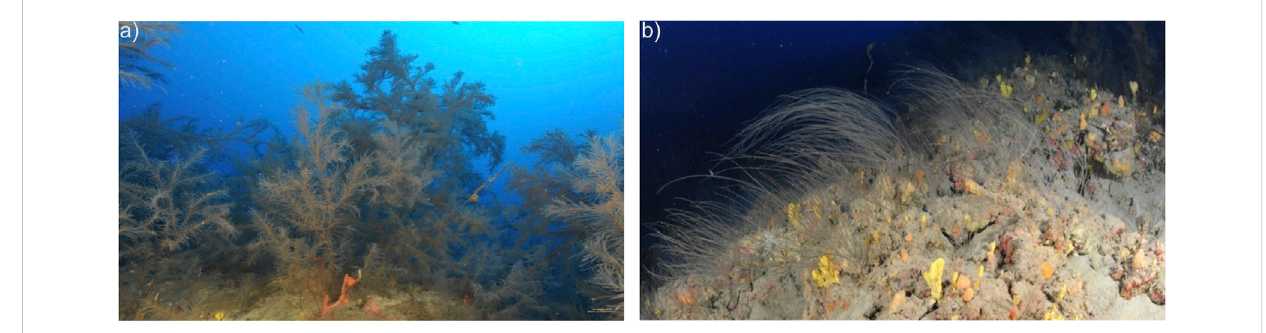
FIGURE 1 (A ) Antipathella wollastoni forms dense forests. (B) It is replaced by Antipathes furcata at around 80 m water depth in the investigation